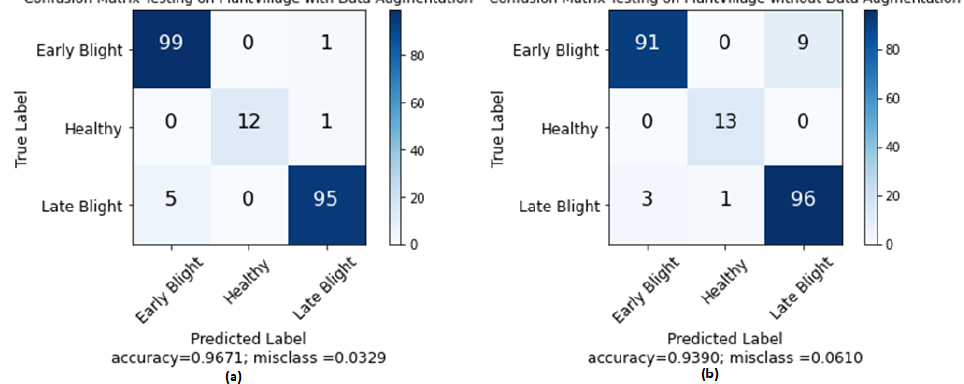
Figure 15. ( a ) PDDCNN confusion matrix on PlantVillage with augmentation. ( b ) PDDCNN confu- sion matrix on PlantVillage without augmentation.